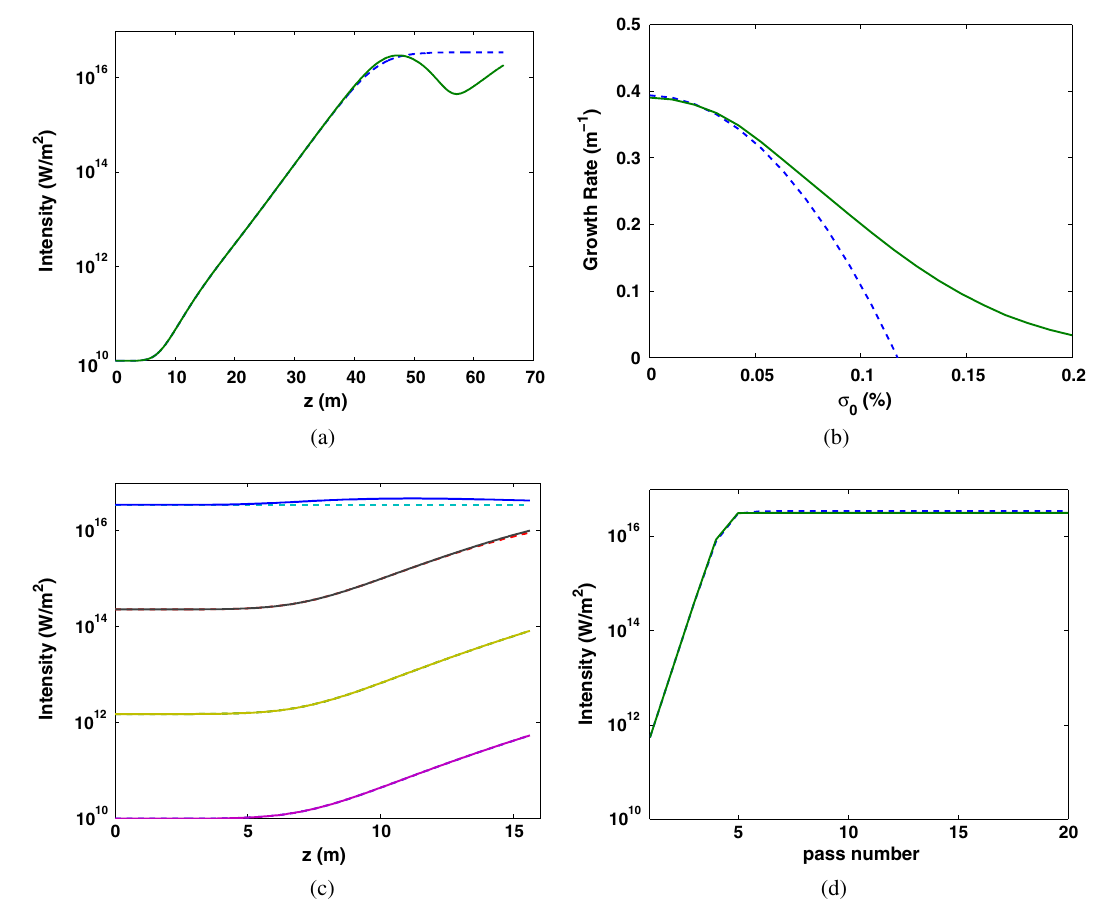
FIG. 2. A comparison of the logistic model (dashed line) to one-dimensional simulations (solid line) for amplifiers and oscillators with 6.5 cm undulator period tuned to resonance at 13.4 nm wavelength: (a) a single, long pass from start-up to saturation; (b) the effect of initial energy spread on growth rate; (c) single-pass simulations for different initial seed power; (d) intensity in a standard oscillator scheme as a function of pass